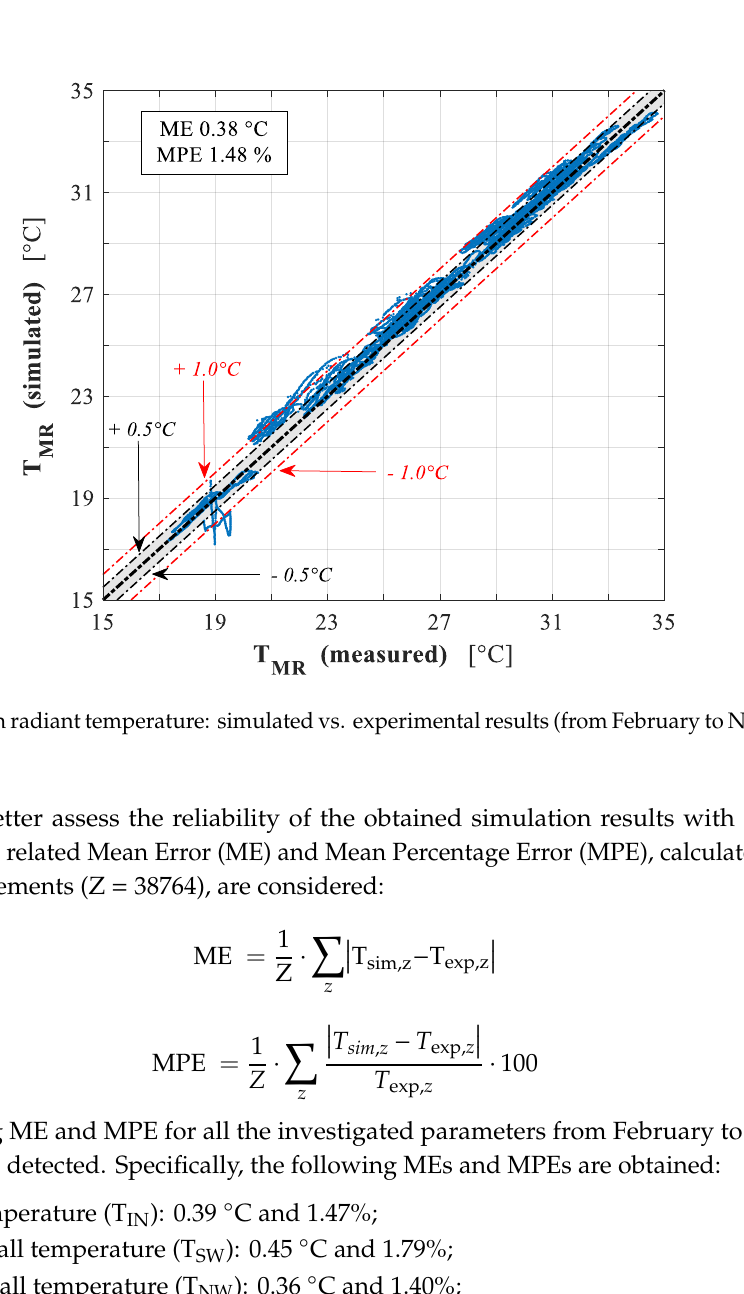
Figure 25. Floor temperature: simulated vs. experimental results (from February to November).